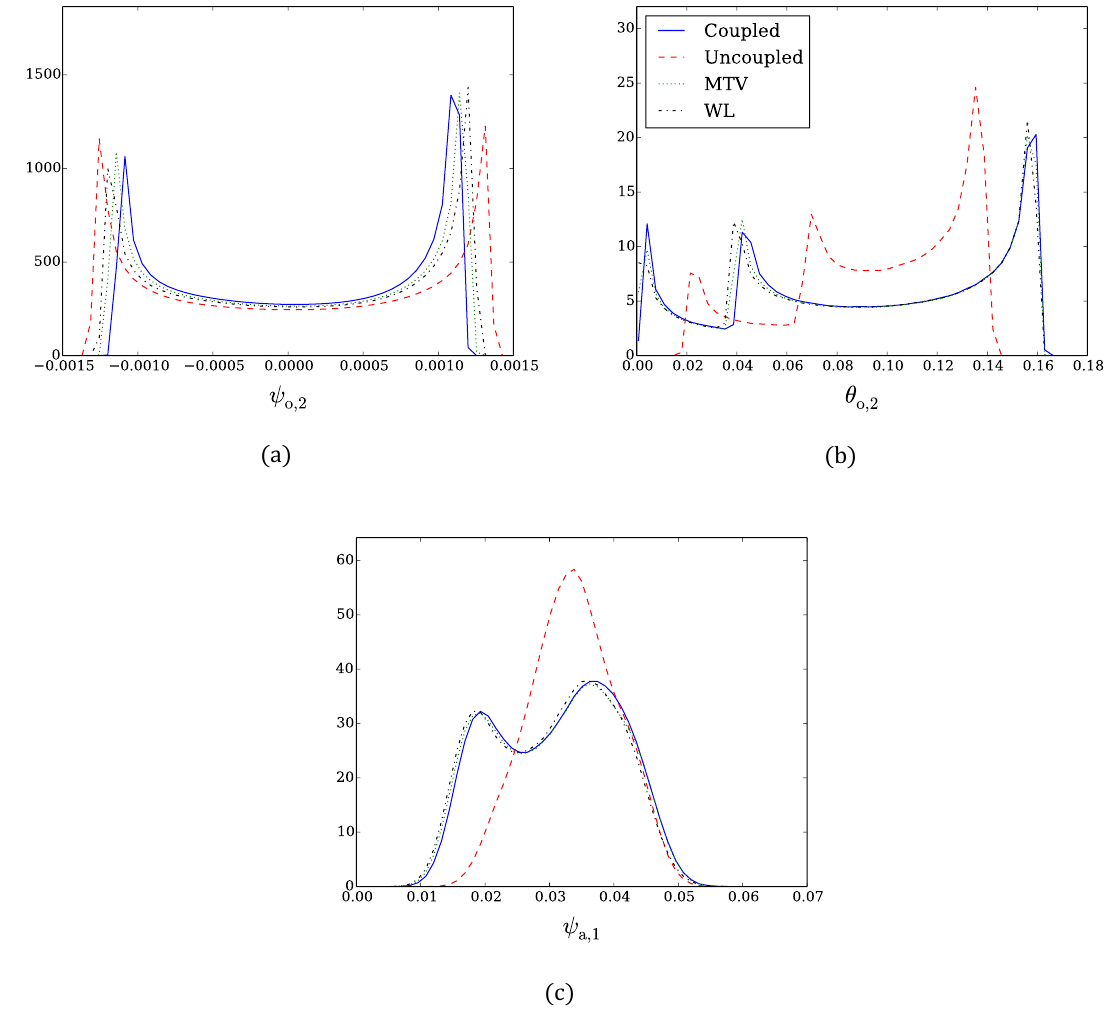
Figure 11. Probability density functions (PDFs) of the dominant variables of the system dynamics as in Fig. 2, but for the wavenumber 2 and F 4 modes parameterization and with the parameter set